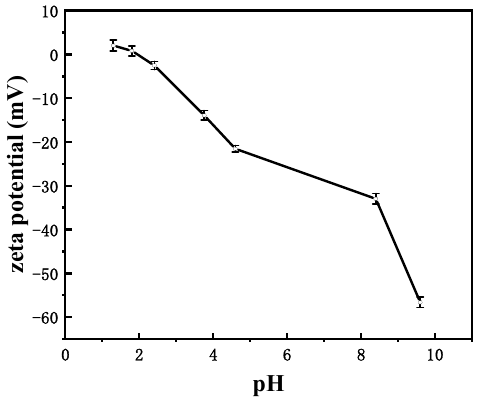
Figure 3. Zeta potentials of synthesized pyrite.